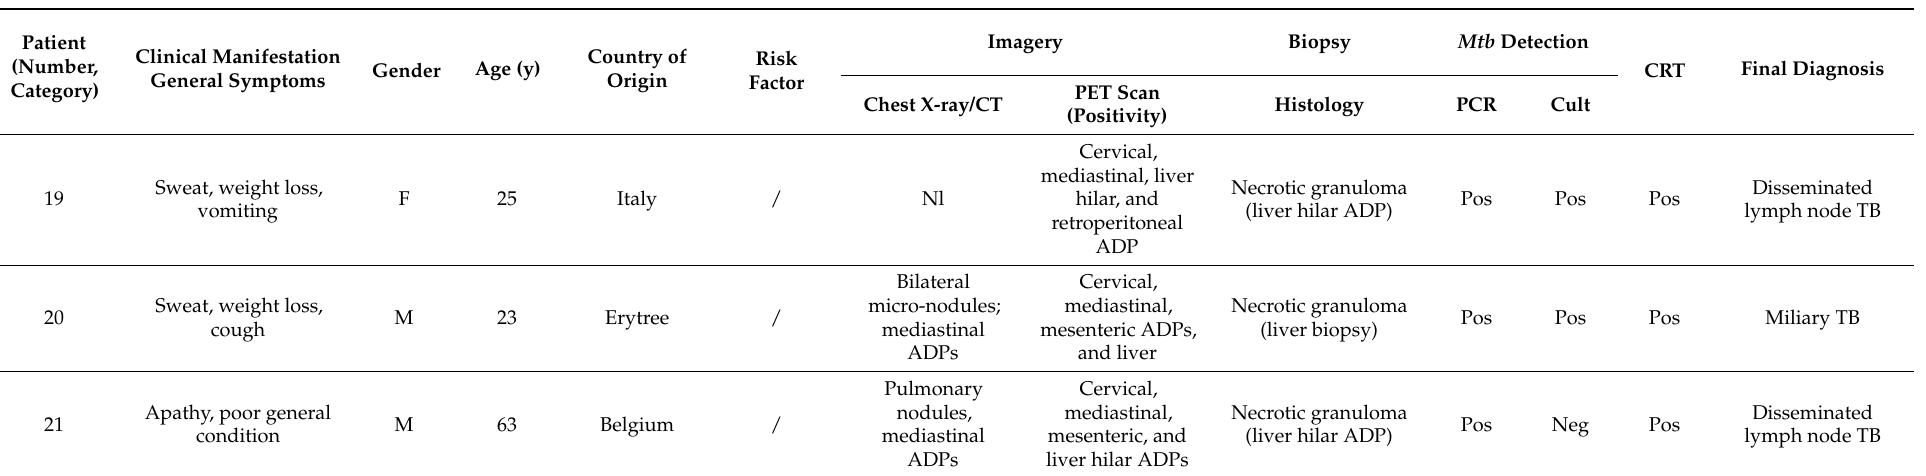
Table 3. Characteristics of patients included in group 3 with disseminated